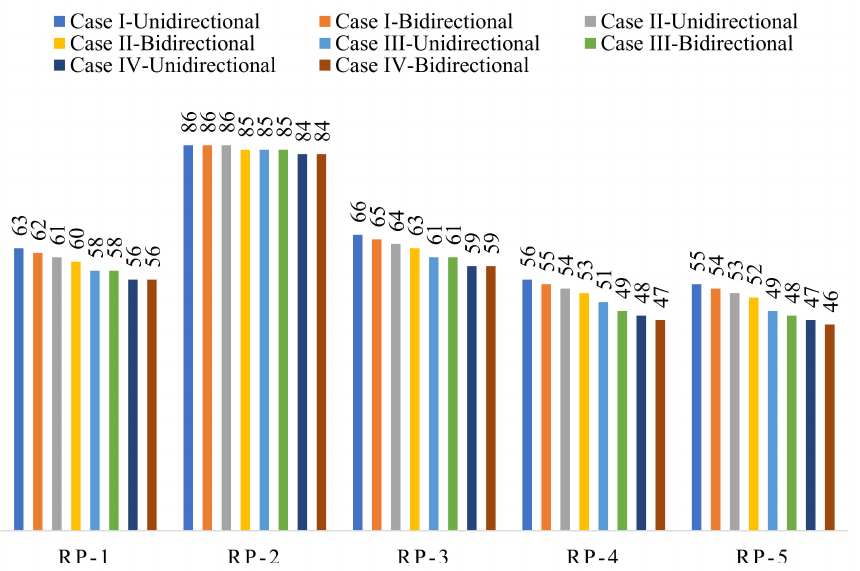
Figure 21. Comparison of unsymmetrical building resilience under unidirectional and bidirectional loading at DBE design level (in percentage).